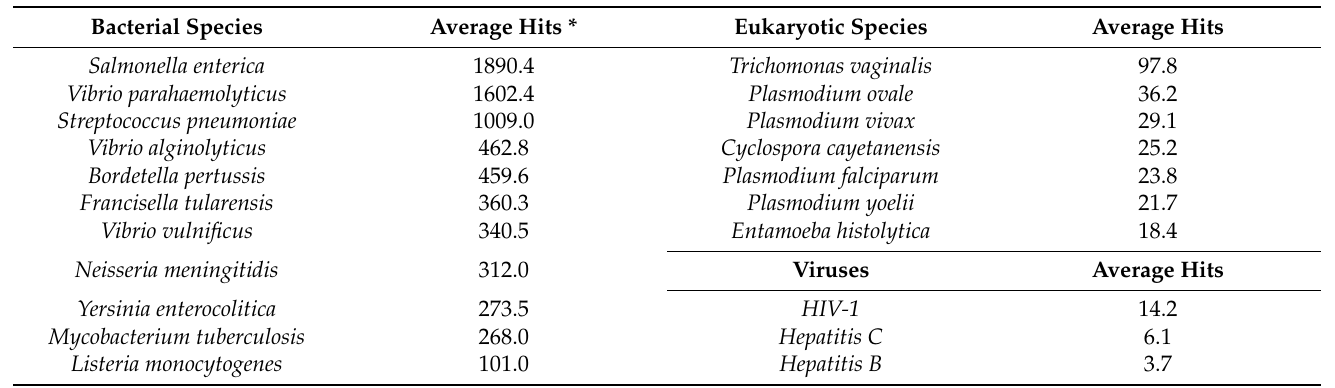
Table 2. List of Disease-Causing Bacteria, Eukaryotes, and Viruses.